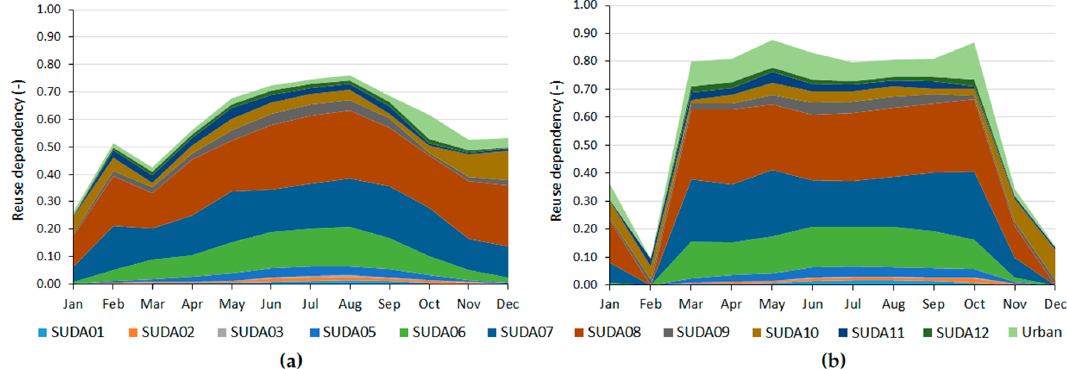
Figure 8. Monthly dependency of the El Hondo wetlands on upstream return flow: ( a ) annual average for the period 2002–2011; ( b ) in 2006, a dry year.